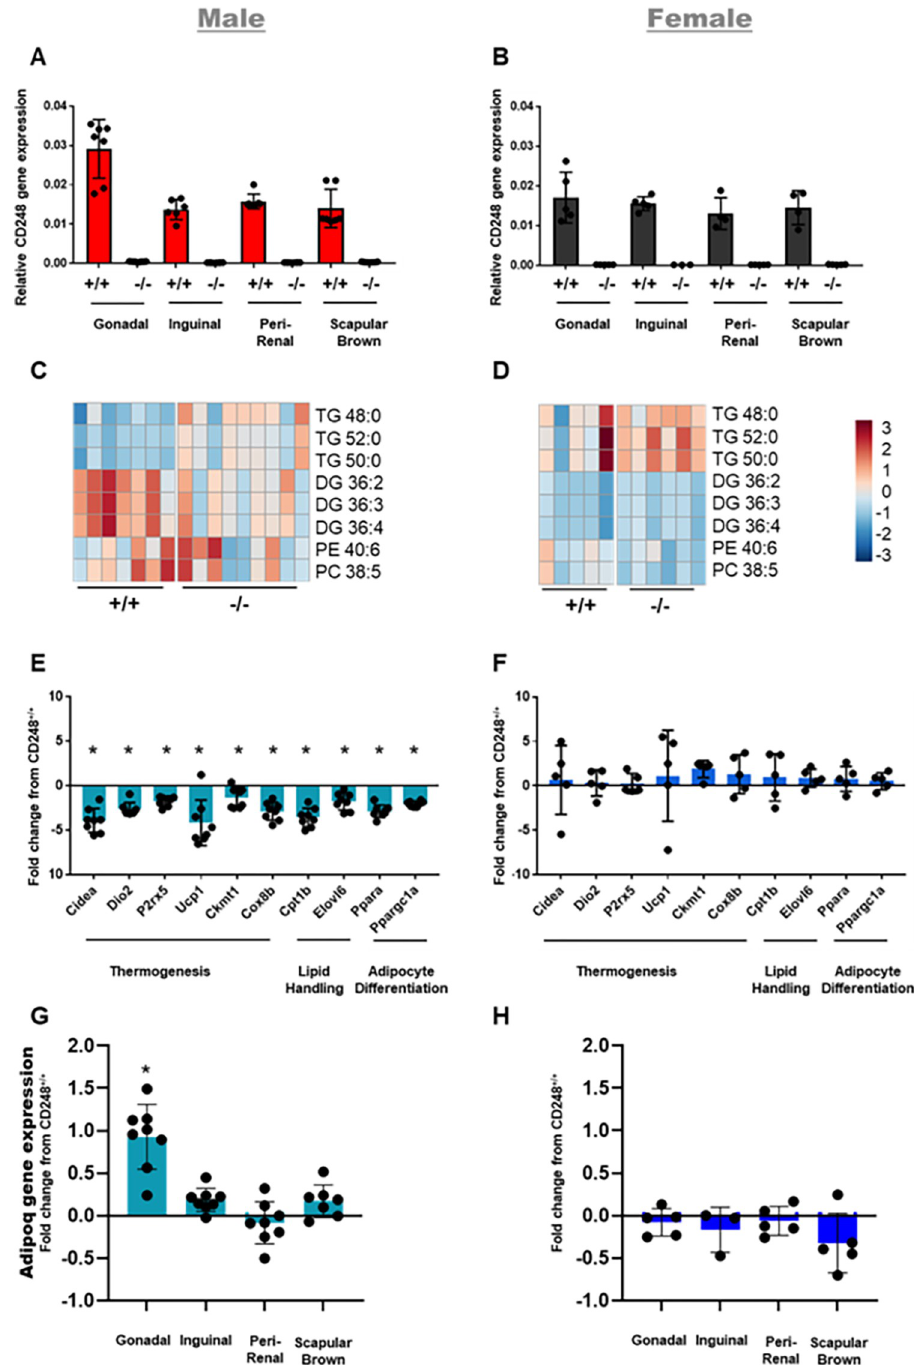
Fig 4. Gene expression and lipidomic results from fat pads following high fat diet feeding for 16 weeks. CD248 expression analysis in each fat pad confirmed loss of CD248 in Cd248 -/- tissues from (A) males (B) females. Heatmap showing z—scores (scale bar from blue = -3 to red = +3 shown—far right) of significantly altered lipids in (C) male Cd248 -/- perirenal fat pad compared to Cd248 +/+ with (D) female shown for comparison where no significant differences were detected. Lipid notation follows the nomenclature described in Liebsch et al . 2013 [22]. Detail of the MSI identification level for each of the lipid species is given in S1 Table . Gene expression array showing significantly altered genes from (E) male Cd248 -/- perirenal fat pad, with (F) female shown for comparison where no significant differences were detected. Adipoq expression data for all four fat depots in ( G ) male and ( H ) female mice are